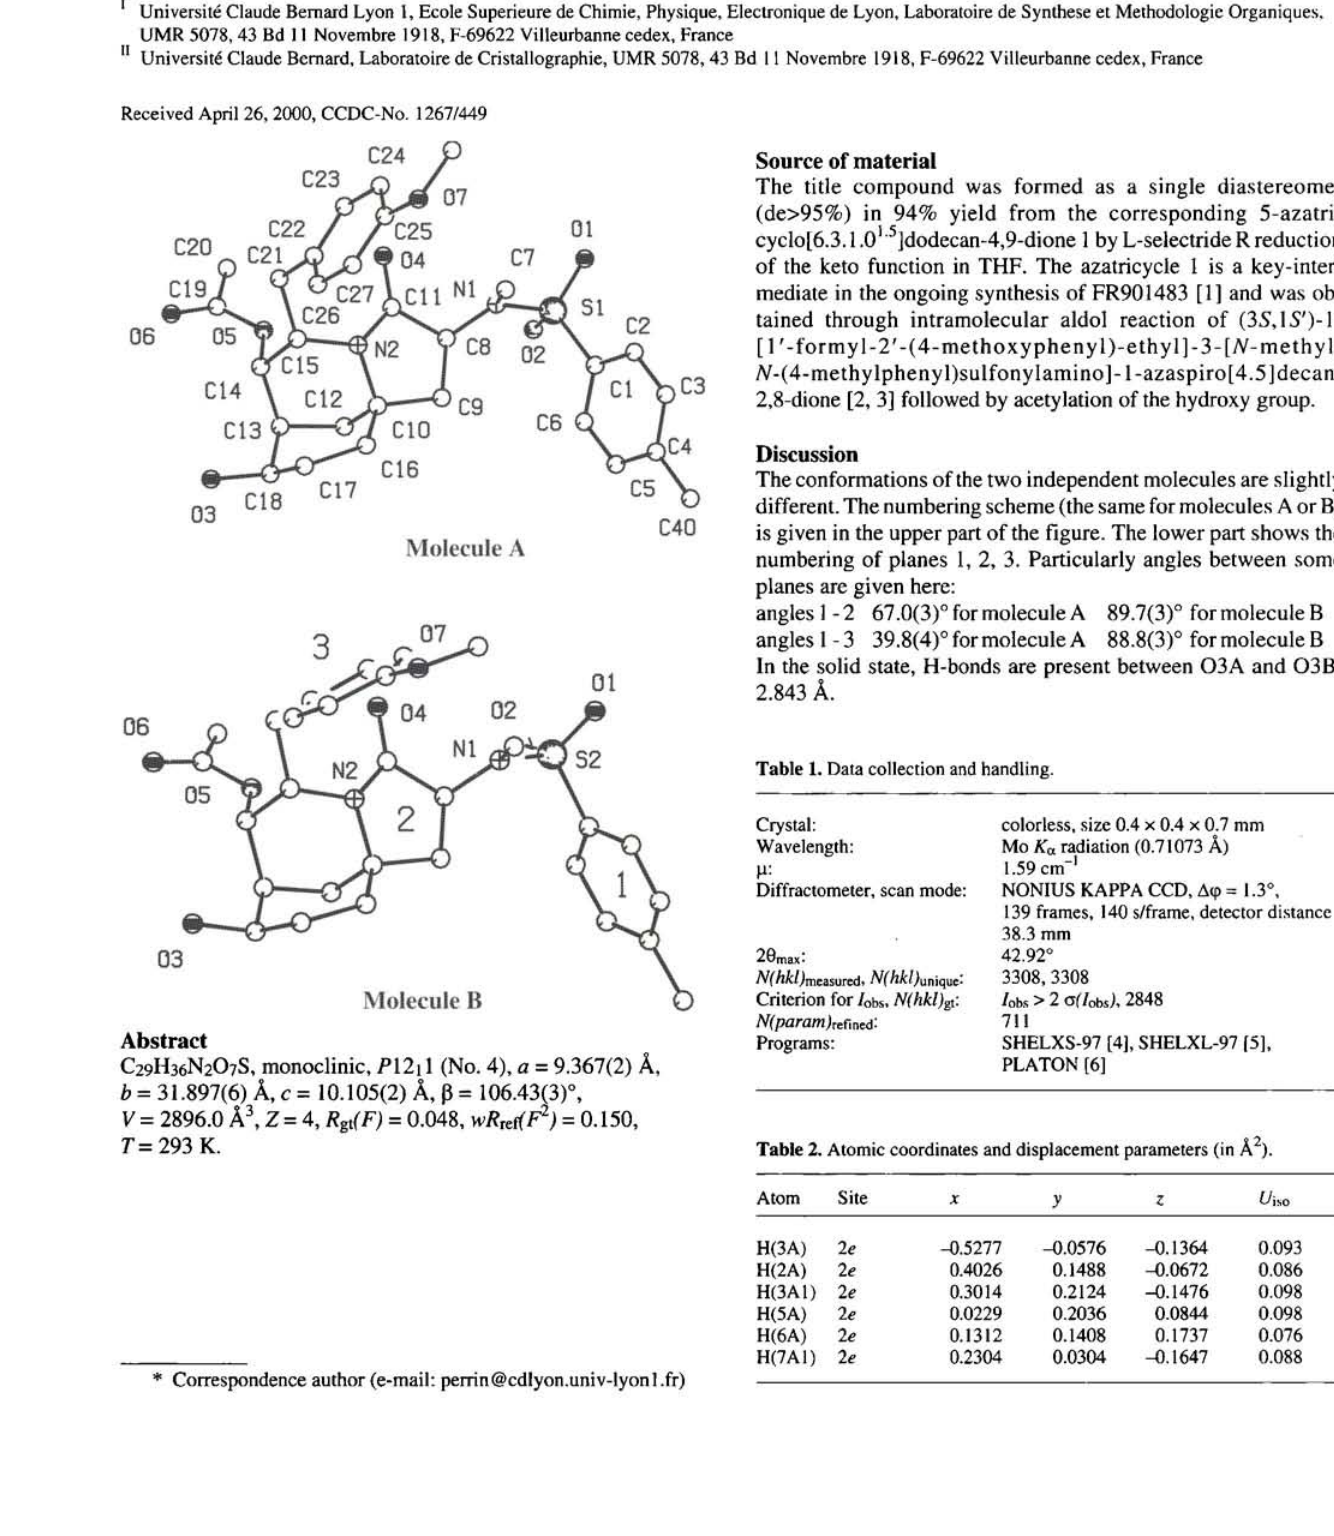
Table 2. Atomic coordinates and displacement parameters (in Â 2